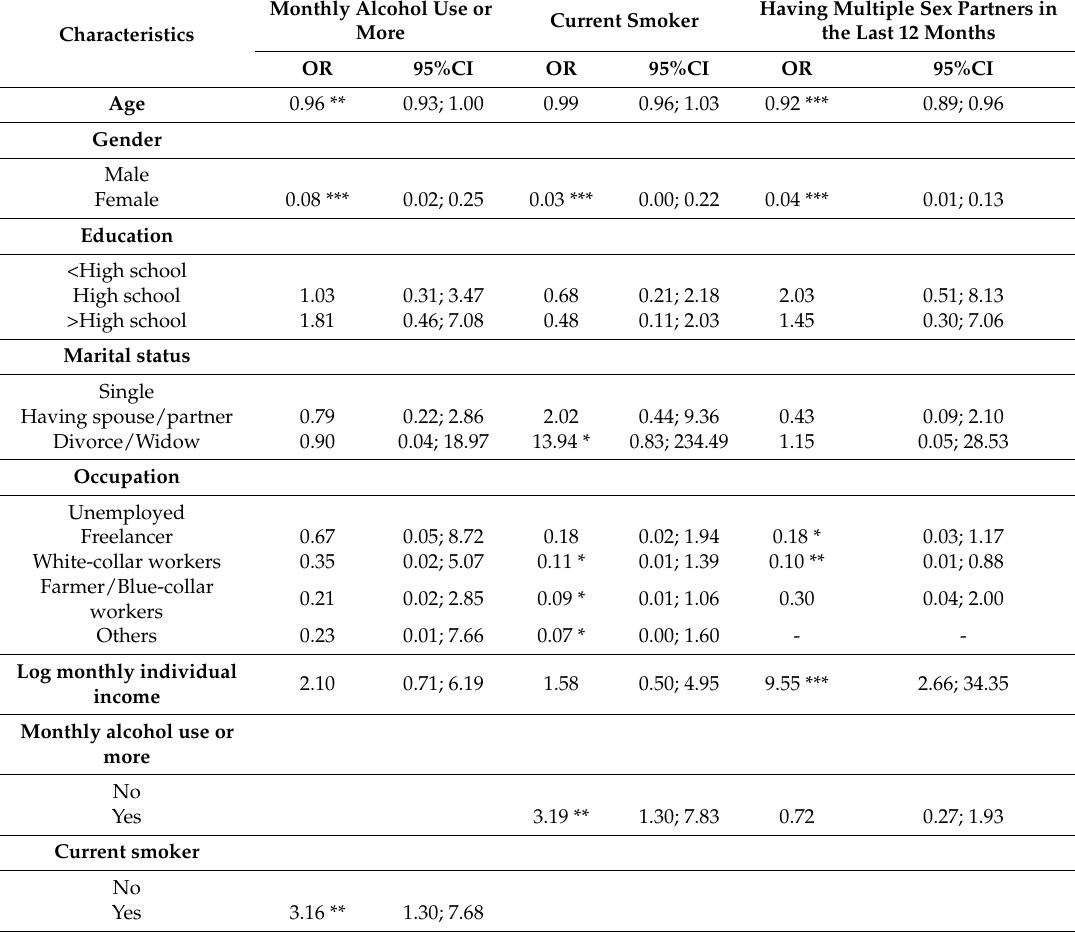
Table 4. Associated factors with risk behaviors among patients with